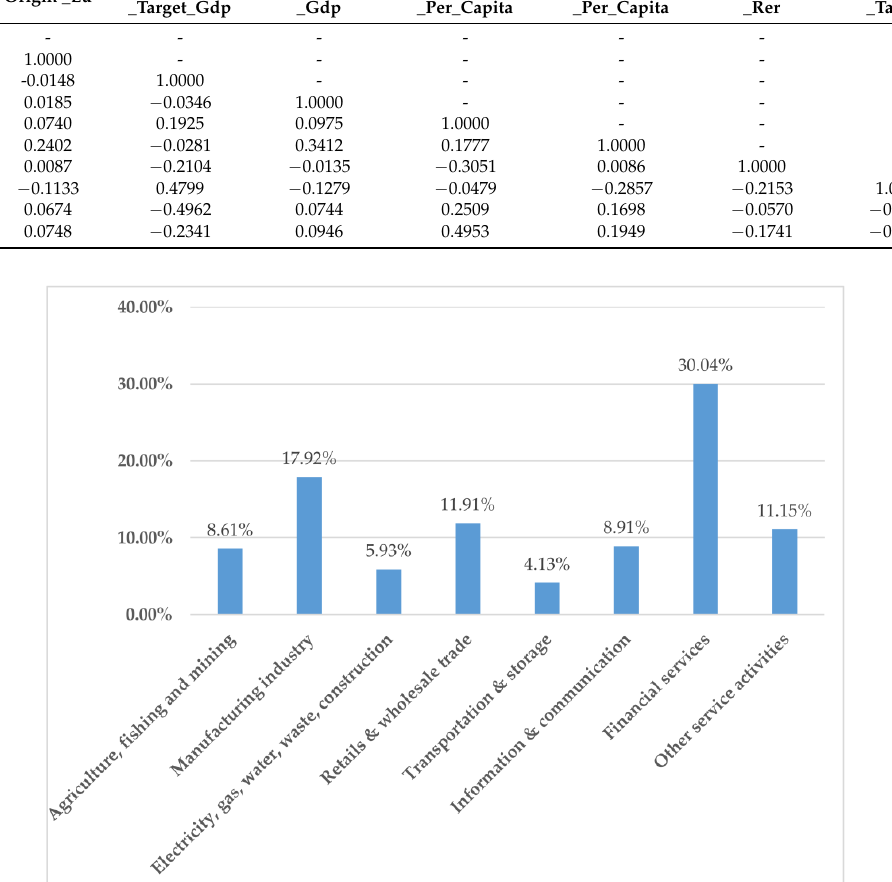
Figure A2. FDI Inward Stock as Percentage of National Capital Stock. Source: UNCTAD. Table A1. Correlation matrix for selected explanatory variables to FDI flow.